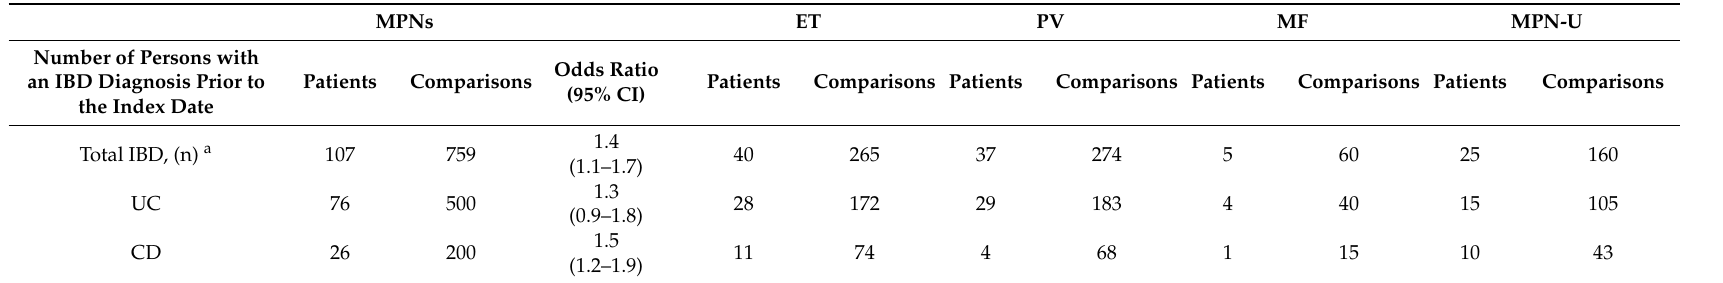
Table 4. Number of IBD diagnoses prior to the diagnosis of myeloproliferative neoplasms. PV MF